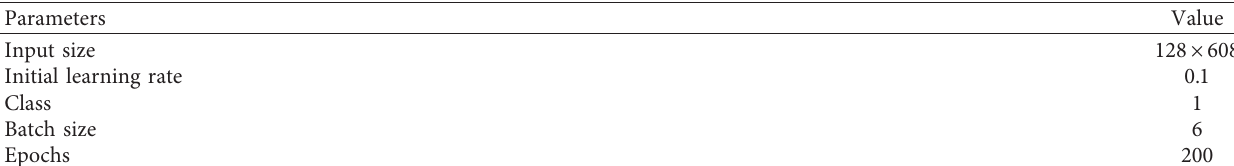
Table 5: Setting of initial parameter values.